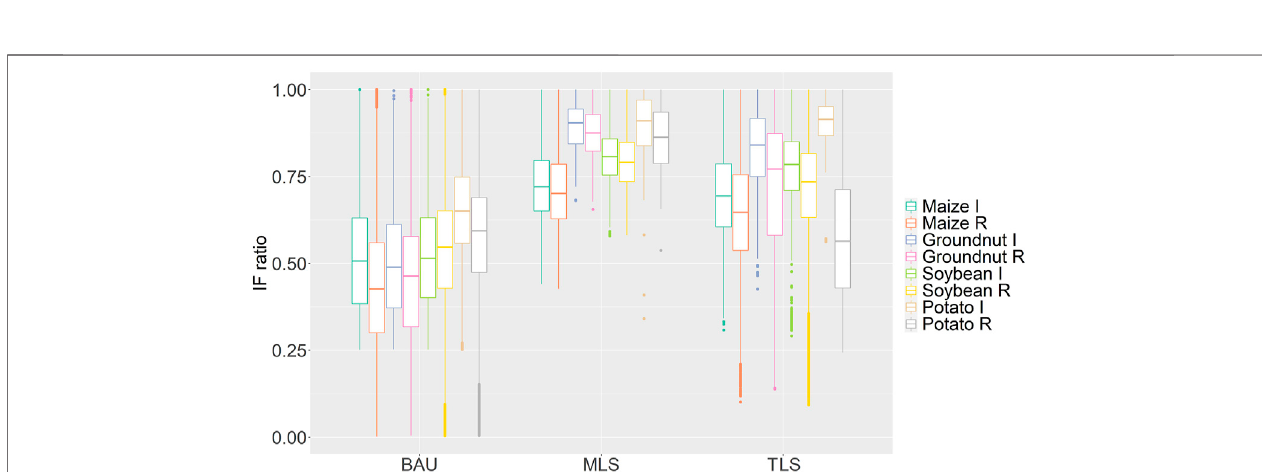
FIGURE 3 | Intensi fi cation factor per crop, simulation unit and water regime (rainfed – R and suf fi ciently irrigated — I) in the business as usual and the land sparing production scenarios. Boxplots display the distribution of intensity of production index (IF) in the business as usual and the two land sparing production scenarios for selected crops. Here we present IF estimates for maize, groundnut, soybean, and potato each as a representative crop, based on the FAOSTAT reported global production volumes, of the crop categories considered in this study (cereals, legumes, oil and protein crops and root vegetables, respectively). The IF index comprises of four basic components estimating intensity of production based on input (N and P fertiliser) and output (current and attainable yields) relationships (see Methods). Globally, production systems of low intensity in both MLS and TLS ( IF < ∼ 0 . 35 and IF < ∼ 0 . 15, respectively), are released, indicating that systems with low production intensity, in BAU either become more intensive or are abandoned